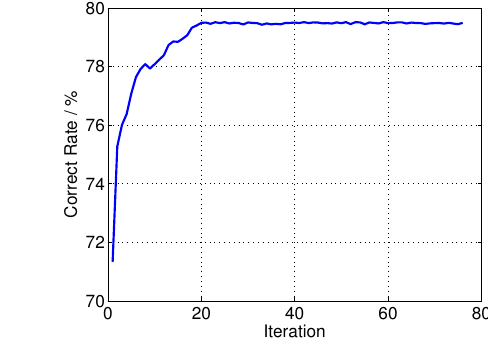
(d) Overall classification result of validation set for each iter- ation.